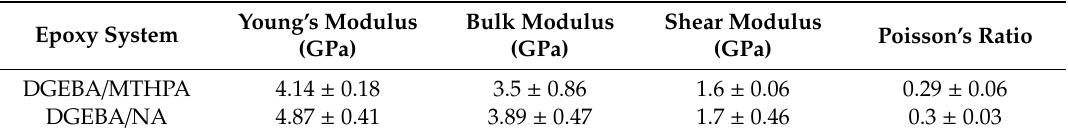
Table 5. The T g of the epoxy systems.